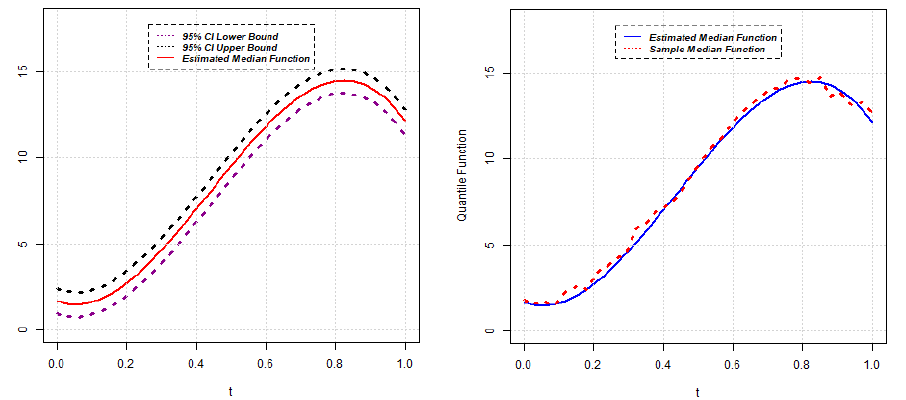
Figure 2. Estimated median function and C.I. ( left ); Estimated median and sample median ( right ) for Model